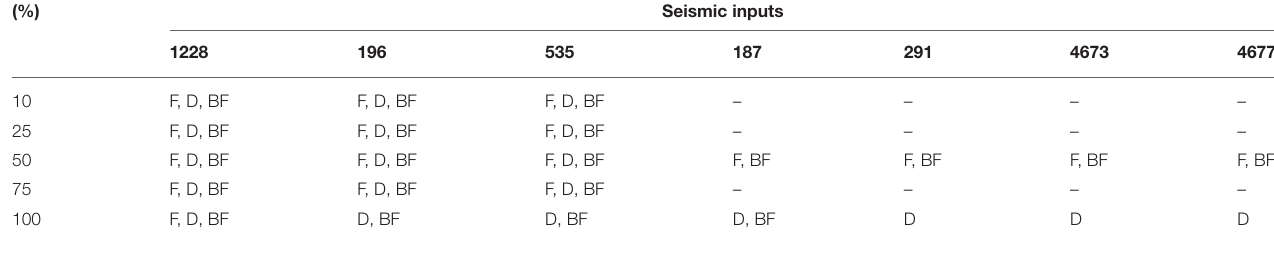
TABLE 1 | Testing program of bare frame (F), with dissipative rocking (D), and with dissipative braces (BF).